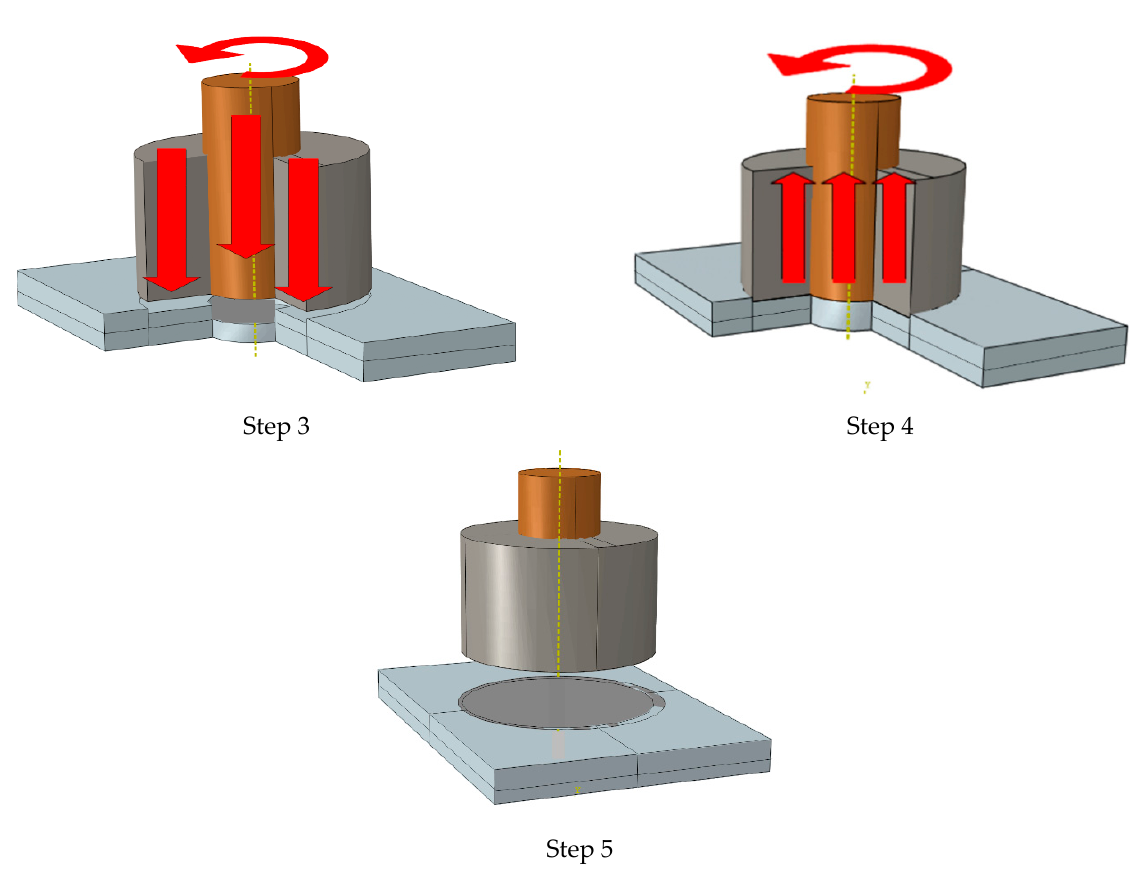
Figure 2. Different steps of FSSW and re ‐ filling process.